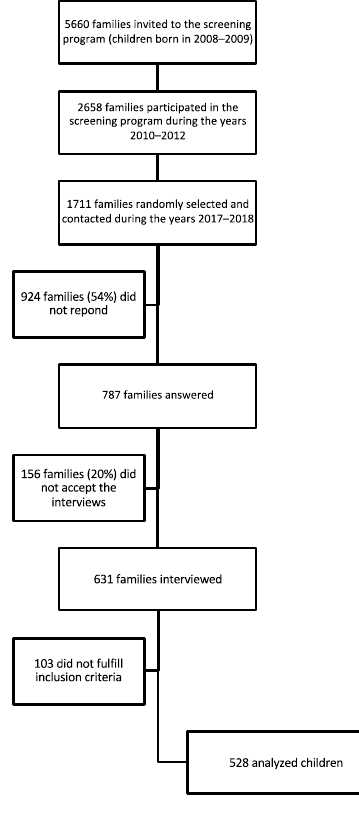
Figure 1. Flow chart of the recruitment.